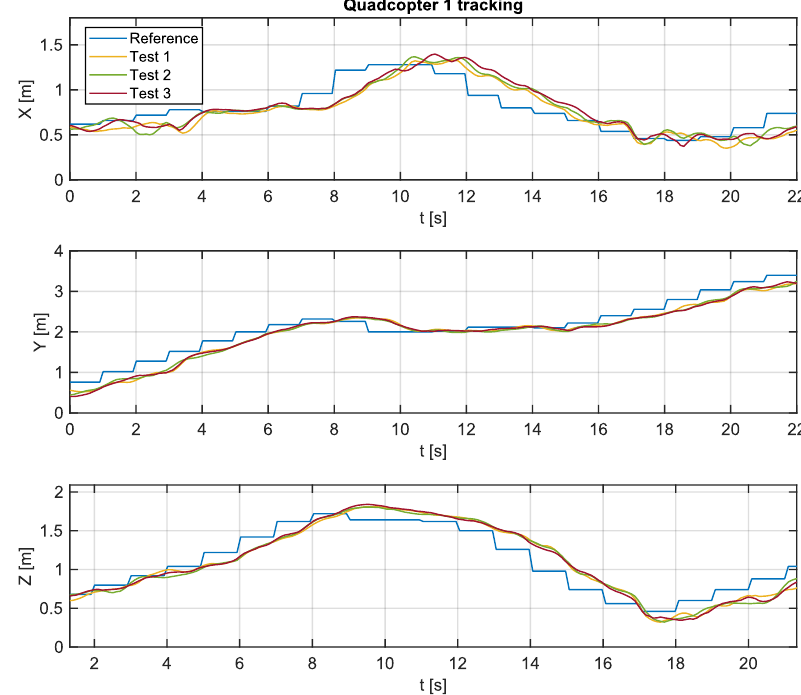
Figure 8. Path tracking of UAV 1.